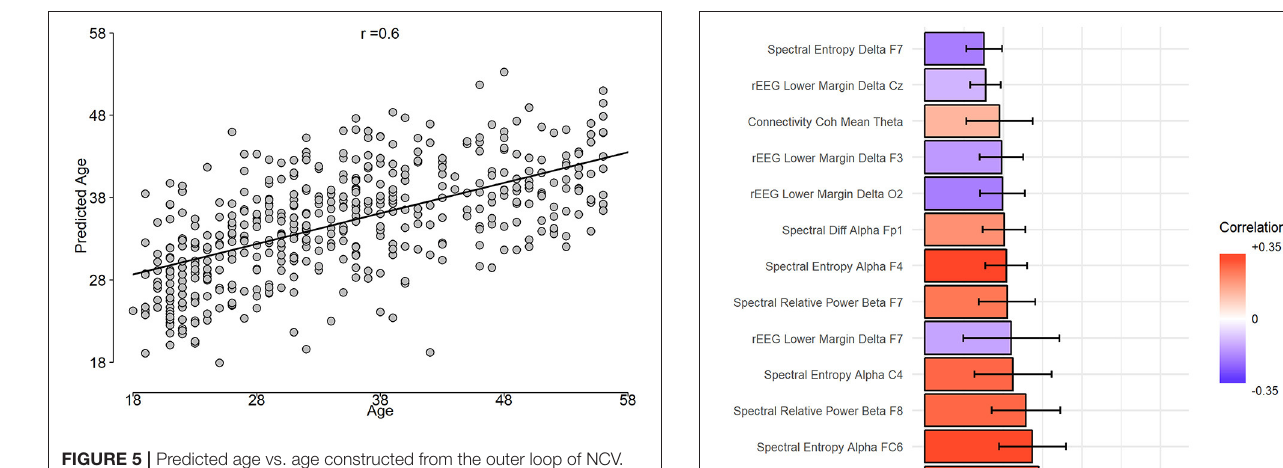
FIGURE 5 | Predicted age vs. age constructed from the outer loop of NCV.